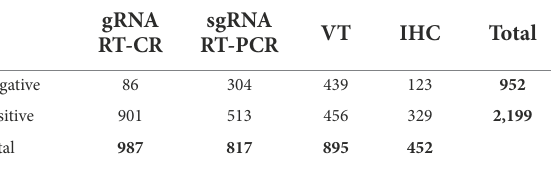
TABLE 2 Frequency of the dichotomised results (positive/negative) by laboratory methods.